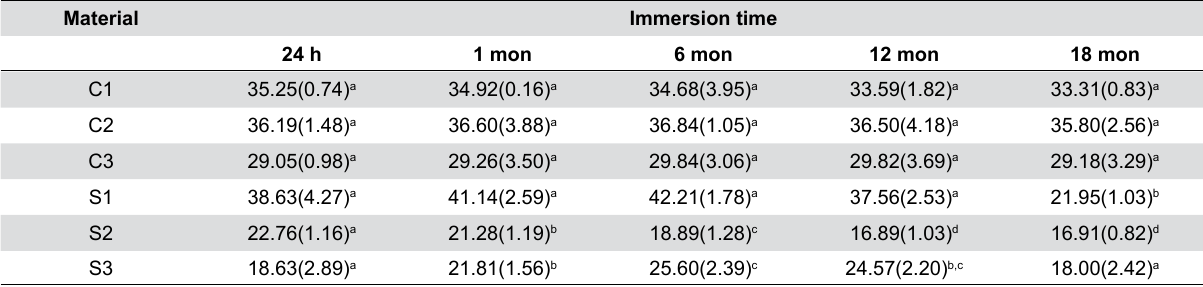
In the conventional resin cement, no significant differences were noted when its values were compared with the corresponding ones prior to the immersion. In self-adhesive resin cement, the same superscript indicates no significant differences compared with the values prior to immersion (24 h)